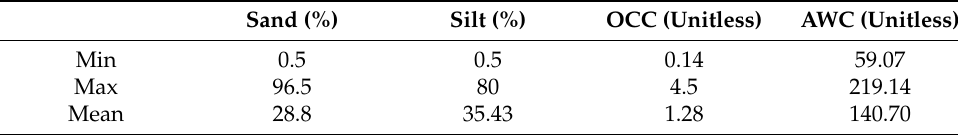
Table 1. Soil data statistics in the study area.